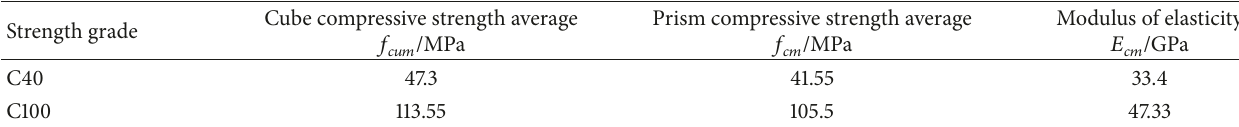
Table 2: Mechanical properties of